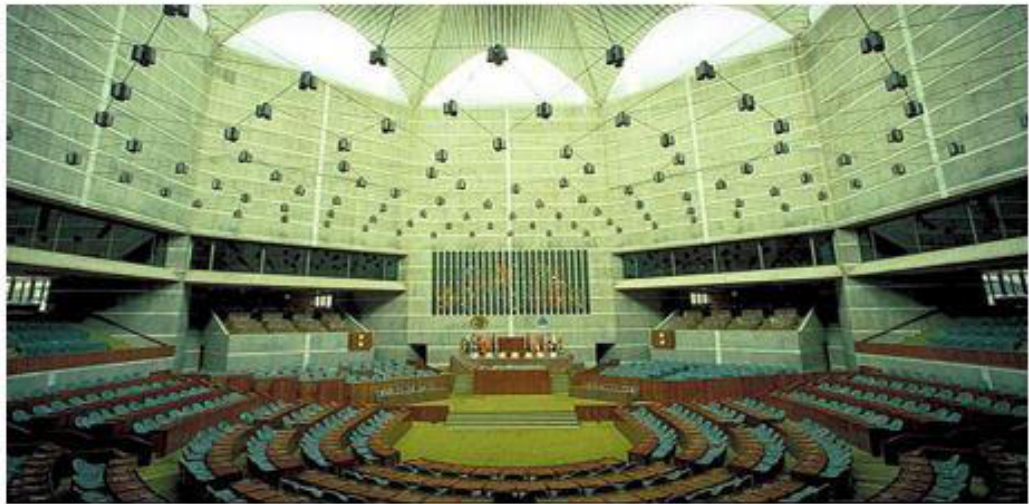
Figure 2. National Parliament House Interior Chamber being lit with rooftop light [Source: www.rethin-